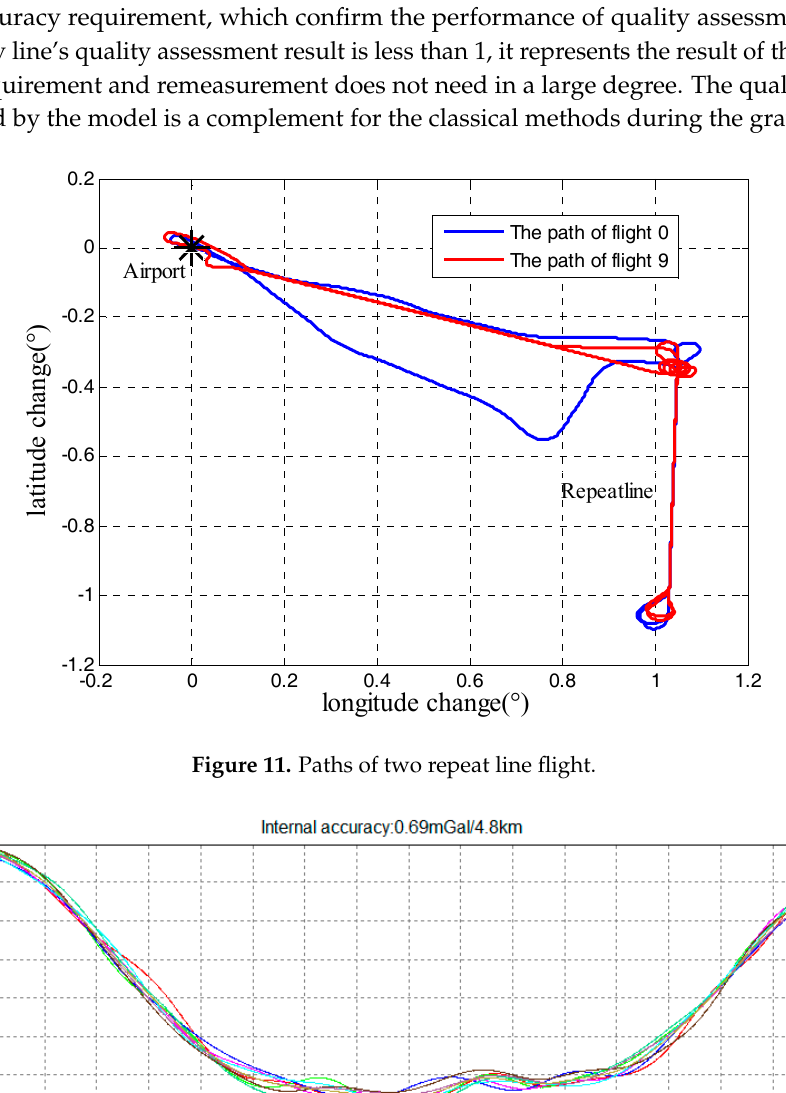
Figure 10. Residuals of new model.